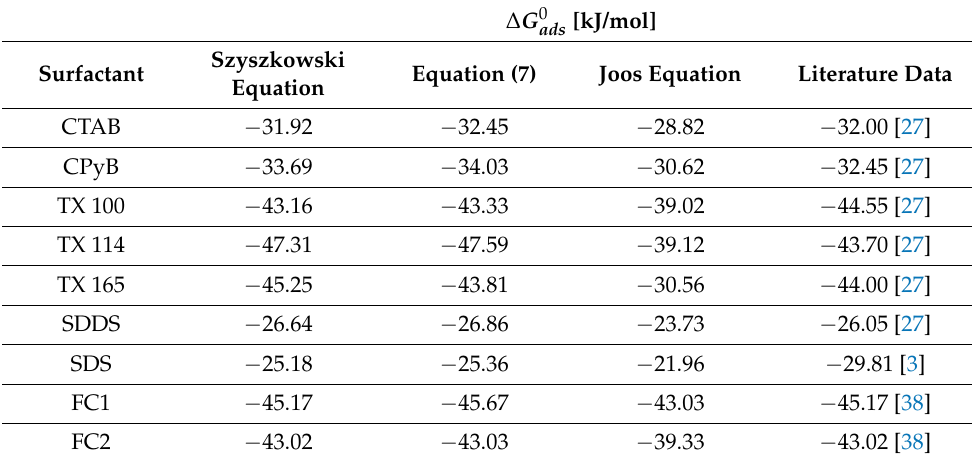
Table 2. The values of standard Gibbs free energy of adsorption of surfactants at the water–air interface ( ∆ G 0 ) calculated from Equation (4) on the basis the constant a in the Szyszkowski and Joos ads equations as well as calculated from Equation (7) and taken from the